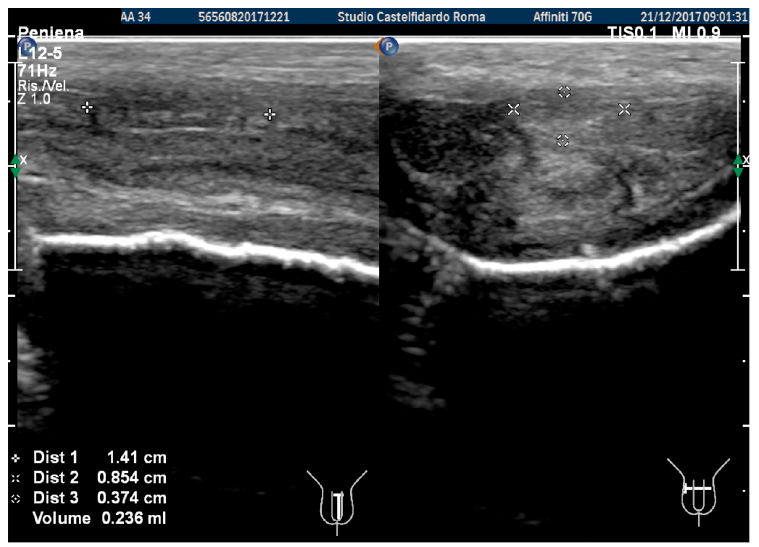
Figure 10. Ultrasonography of the penis after the 1st therapy cycle (longitudinal and axial views). Compared to its initial measurement, the plaque had therefore undergone a 67.4% reduction in volume.